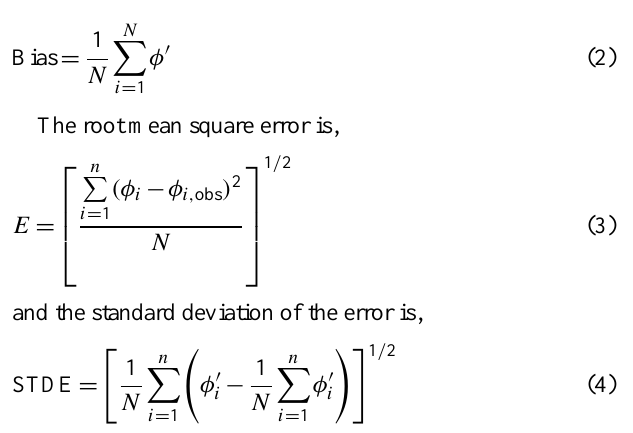
Fig. 2. WRF domains D1, D2 and D3 with horizontal resolutions of 25, 5 and 1 km respectively. (Ferreira A.P., 2007) applied the WRF model to mainland Portugal, performed numerical exper- iments with several sets of physical parameterizations and compared the results with observed data with the aim of finding the best combination of parameterizations. The set of parameterizations that 85 (Ferreira A.P., 2007) found to give the best results where used in the present study. Hence, the fol- lowing schemes were used in all simulations: WRF Single-Moment 6-class scheme microphysics (Hong et al., 2006), Goddard shortwave radiation (Skamarock et al., 2008), Rapid Radiative Trans- fer Model (RRTM) longwave radiation model (Mlawer et al., 1997), the Eta similarity surface layer